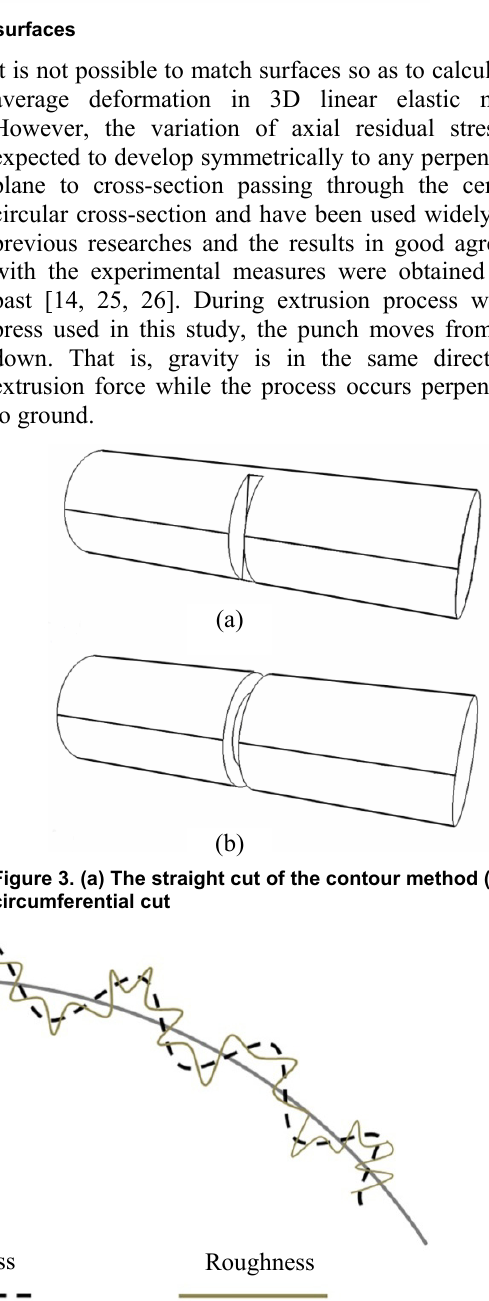
Figure 4. The illustration of surface adopted